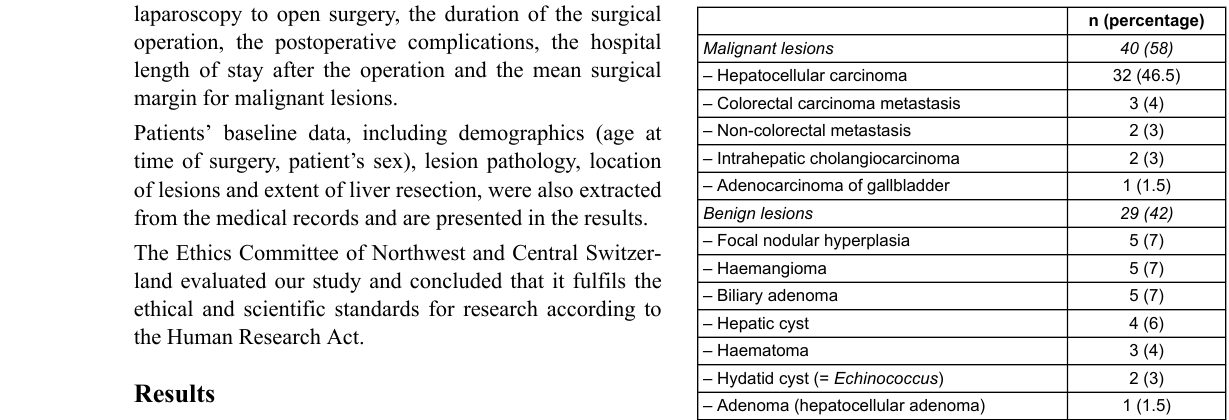
Table 1: Histological diagnoses in 69 laparoscopic operations on the liver.